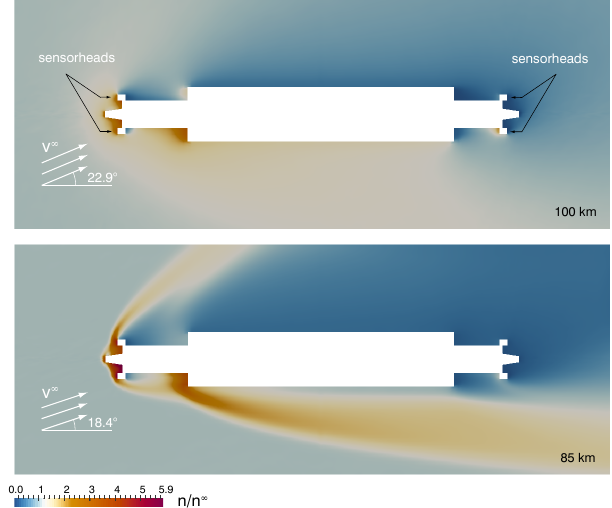
Figure 9. Distribution of the ratio between local and free-stream number density during the downleg at two different altitudes. Re- sults from 3D DSMC calculations with the PICLas